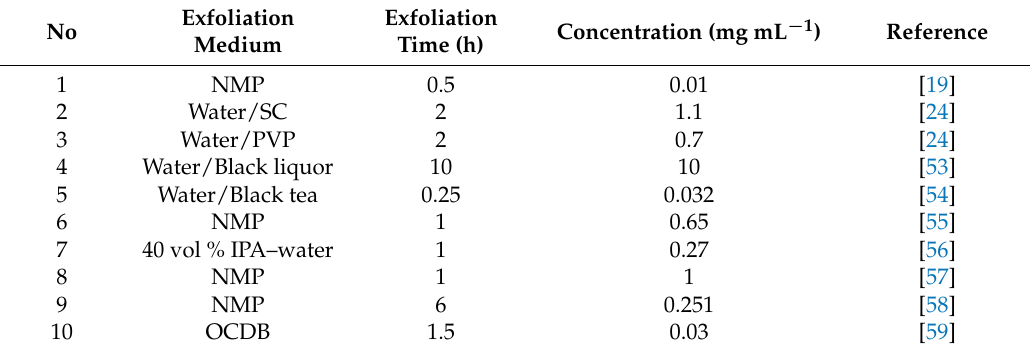
Table 3. Concentration of graphene produced via high-shear mixing in various solvents